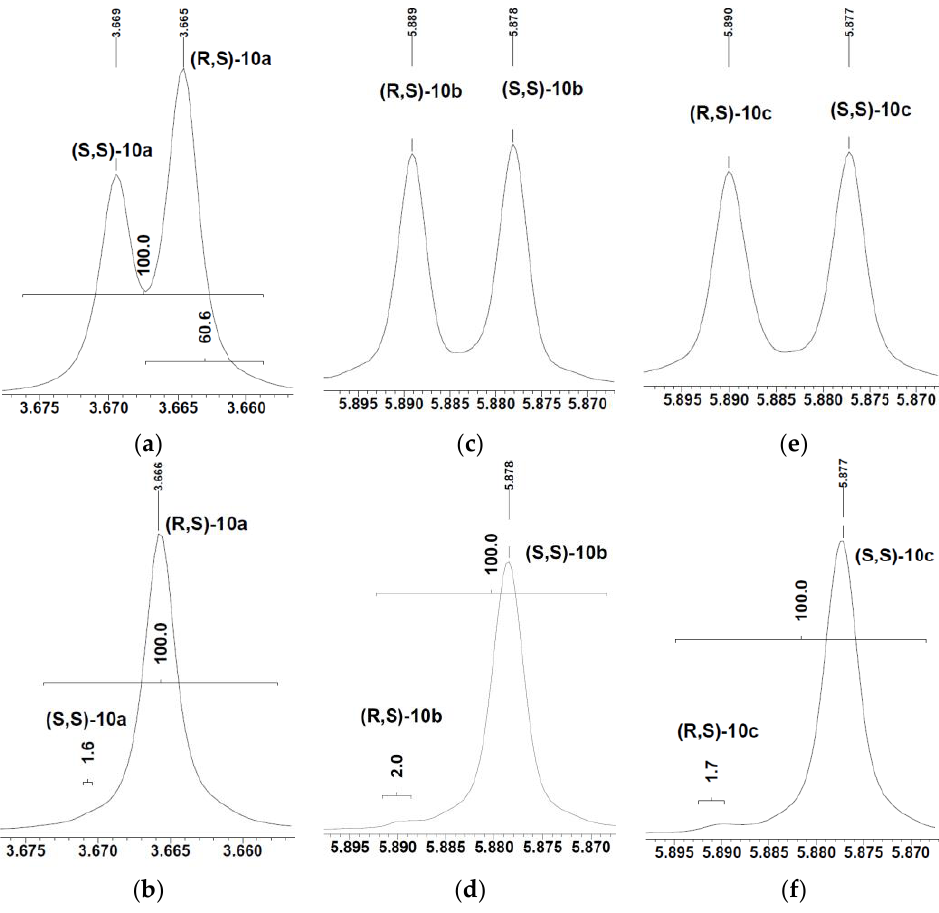
Figure 6. 1 H-NMR analysis of the diastereoisomeric mixtures of ( S )- O -acetylmandelate esters 10a – c